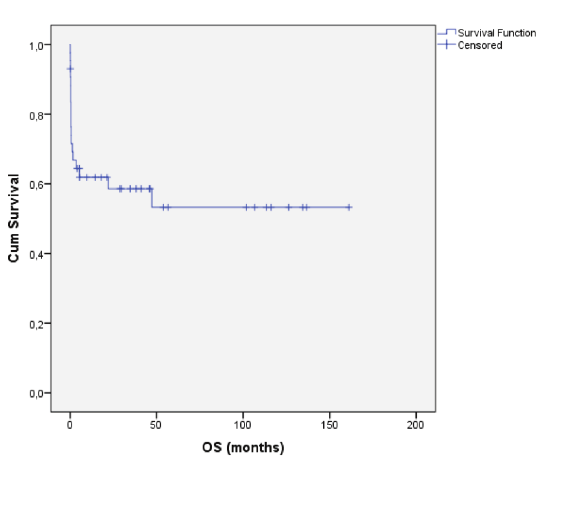
Figure 1: Overall survival of APL